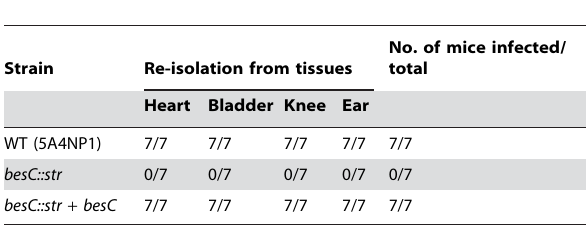
Table 2. Mouse infection study using B. burgdorferi wild-type, besC::str mutant and complemented